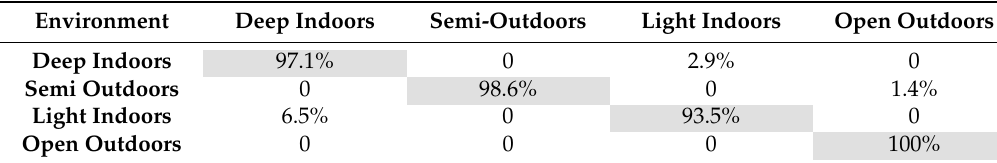
Table 4. Confusion matrix using four stations’ signal strength with KNN classifier.